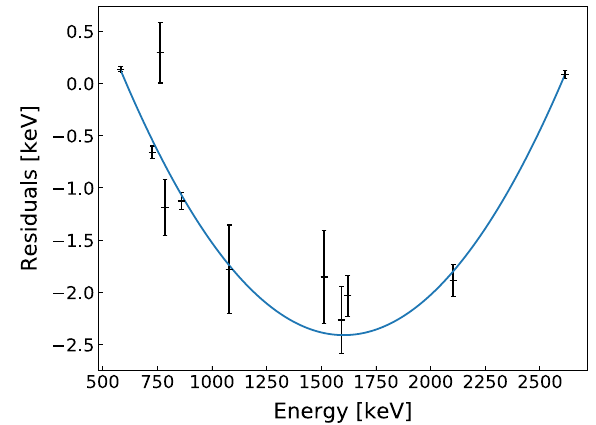
Fig. 2 Fitting the residuals of the calibration curve with a quadratic function, as shown for detector ANG2 for the calibration on 15th Octo- ber